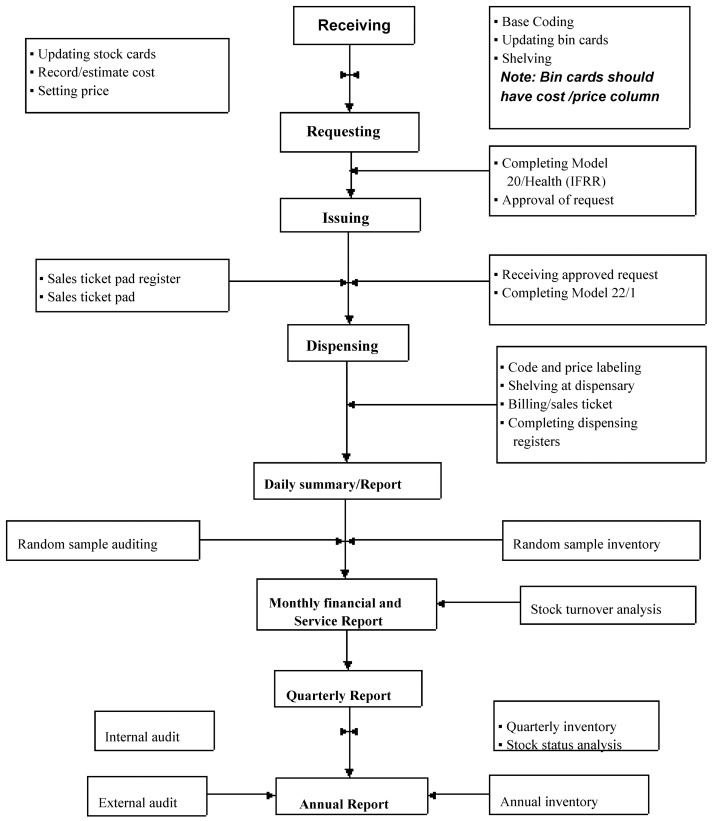
APTS transaction at health facility (Source: APTS training guideline, 2016).